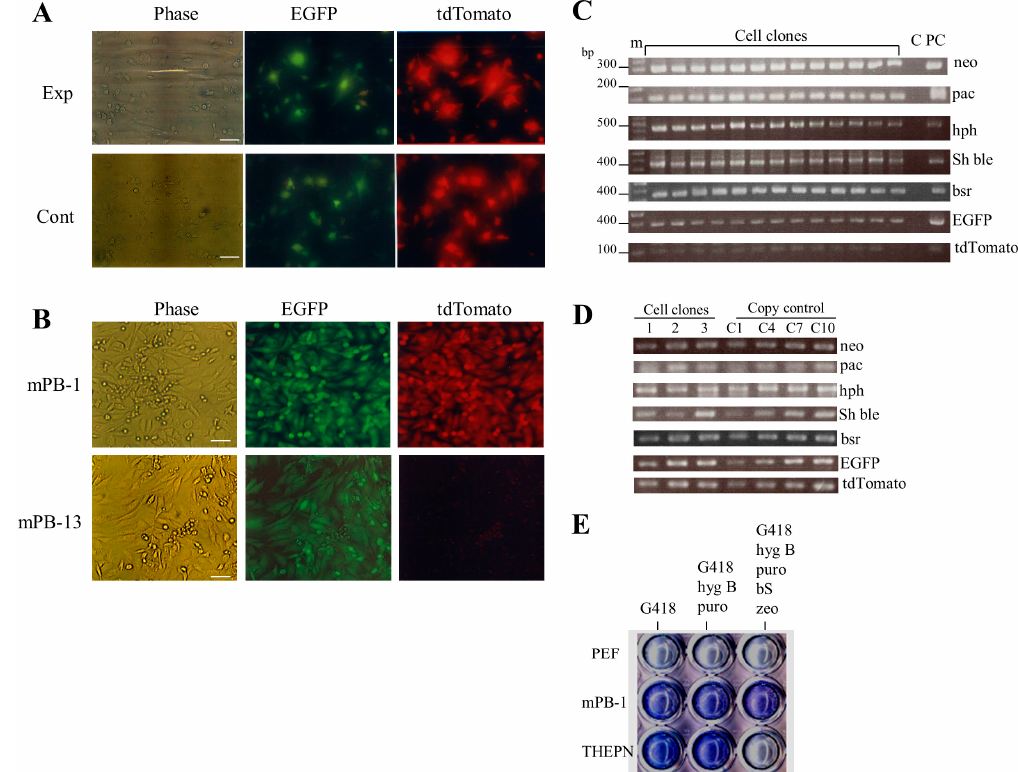
Figure 2. Acquisition of stable PEF transfectants after simultaneous transfection with seven PB vectors. ( A ) Fluorescence micrographs of PEFs one day after transfection in the presence (experimental group, Exp) or absence (control group, Cont) of pTrans. Note that in both transfection groups there are some cells exhibiting both green and red fluorescence, but no significant difference in gene transfer efficiency between these two groups was observed. Phase, taken under light; tdTomato, red fluorescence derived from tdTomato in pT-tdTomato; and EGFP, green fluorescence derived from EGFP in pT-EGFP. Scale bars = 20 µ m; ( B ) fluorescence micrographs of stable PEF transfectants (m PB -1 and m PB -13). Note that m PB -1 exhibited both green and red fluorescence, whereas only green fluorescence was observed for m PB -13. The abbreviations above each figure are the same as shown in ( A ). Scale bars = 20 µ m; ( C ) PCR analysis of stable PEF transfectants (numbered m PB -1 to 13). Genomic DNA isolated from each transfectant was subjected to regular PCR using the primer sets shown in the Materials and Methods. m, 100-bp ladder markers; lane C, normal PEFs; lane PC, control plasmids (pT-neo for detection of neo , pT-pac for detection of pac , pT-hph for detection of hph , pT-Sh ble for detection of Sh ble , pT-bsr for detection of bsr , pT-EGFP for detection of EGFP cDNA, and pT-tdTomato for detection of tdTomato cDNA); ( D ) determination of the number of copies of the introduced transposon DNA in the PEF transfectants (m PB -1 (lane 1), -2 (lane 2), and -3 (lane 3)). C1, C4, C7, and C10 indicate PEF DNA plus one, four, seven, or 10 copies of transposon DNA, respectively; ( E ) Assay of drug sensitivity in stable PEF transfectants. Cells (m PB -1, THEPN, and untransfected PEFs (PEF)) were plated in a 48-well plate, and cultured in medium containing G418, medium containing G418 + hygromycin B (hyg B) + puromycin (puro), or medium containing G418 + hyg B + puro + blasticidin S (bS) + zeocin (zeo), for 10 days. After culturing, cells were stained with Giemsa stain for visualization.